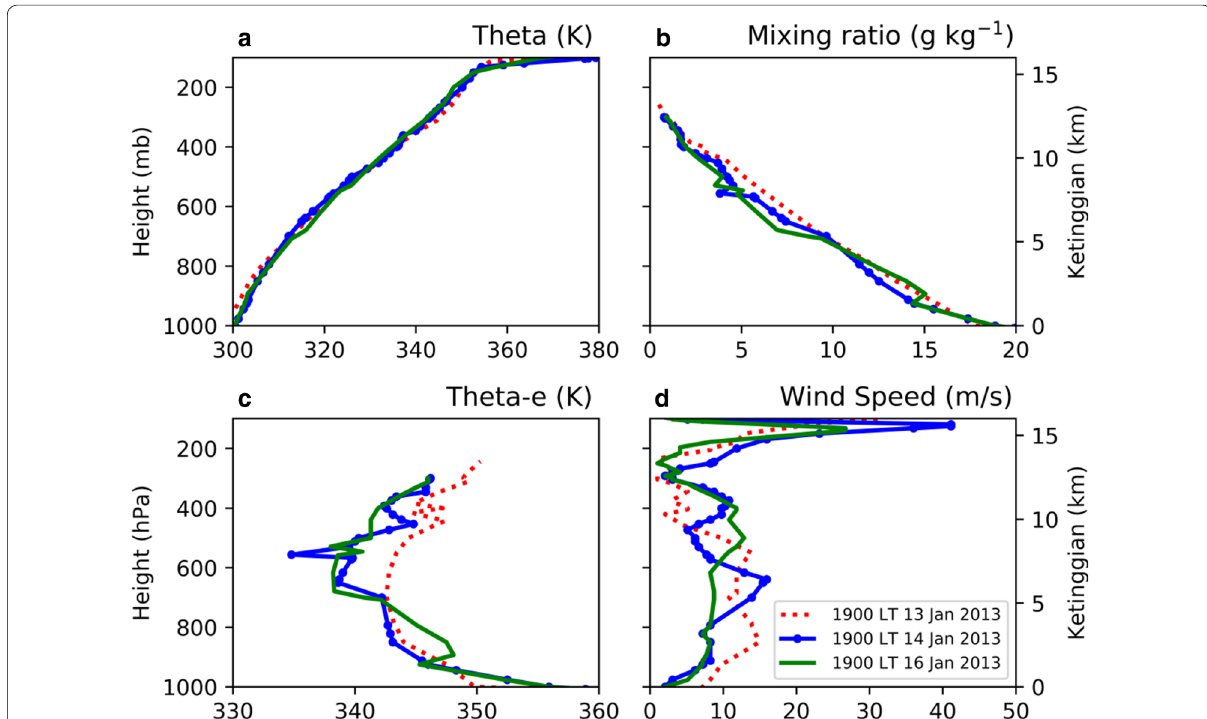
Fig. 10 Profile of a potential temperature (theta, K), b mixing ratio (g/kg), c equivalent potential temperature (theta-e, K), and d horizontal wind speed (m/s) from upper-air sounding observation at Cengkareng during evening (19:00 LT) prior of MCS events. The dotted curve denotes the atmospheric condition of no-MCS event, the dotted line curve indicates the atmospheric condition first MCS event and the line curve shows the atmospheric condition of next MCS